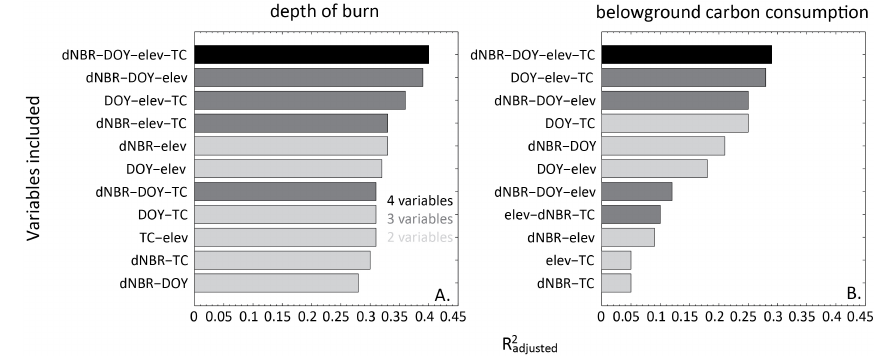
Figure 4. Relative importance of variables assessed from the nonlinear multiplicative models using all different combinations of two or more variables for (a) depth of burn and (b) belowground carbon consumption. Since only two variables were included in the aboveground carbon consumption model, no similar analysis was performed for aboveground carbon consumption. dNBR: differenced normalized burn ratio, DOY: day of the year, tc: tree cover, elev: elevation.